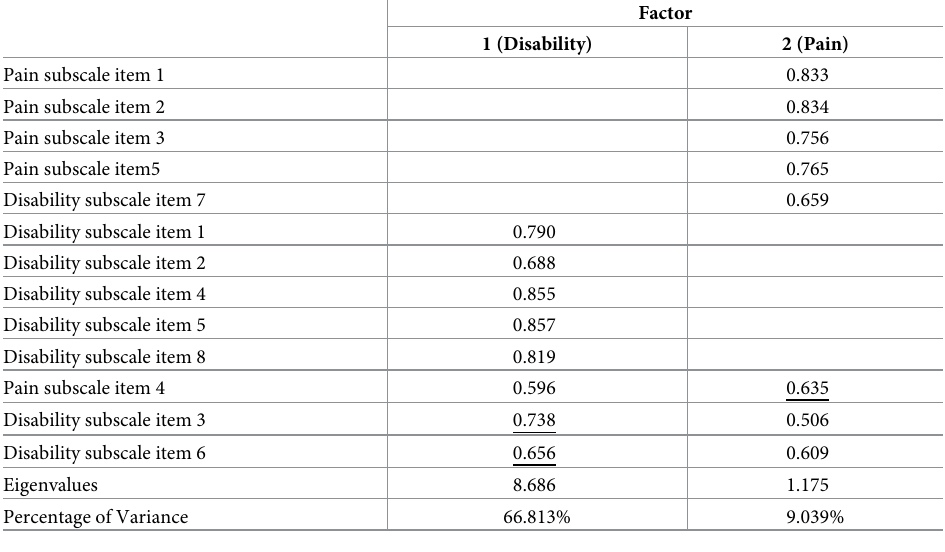
Table 3. Exploratory factor analysis of